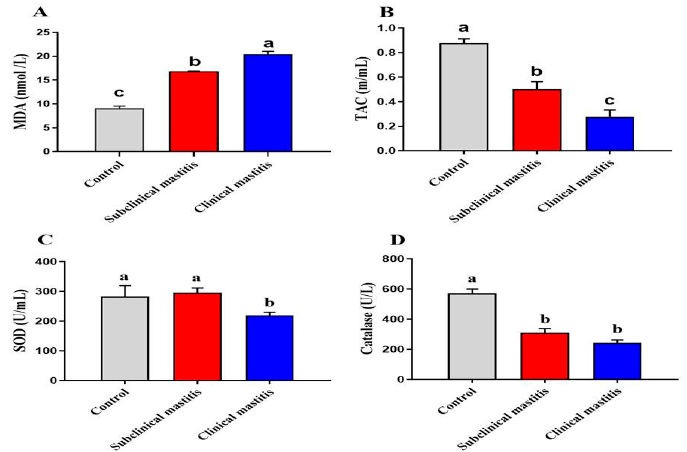
Figure 3. Serum antioxidant/oxidative stress parameters of dairy cows with subclinical and clinical mastitis. Data were represented as Mean ± SME. This means in with different superscripts are significantly different ( p < 0.05). a significantly different from b and c, a for the high value, b for intermediate value between a and c, while c for the lower value. Malondialdehyde (MDA, A ), total antioxidant capacity (TAC, B ), Superoxide dismutase (SOD, C ), and catalase ( D ).